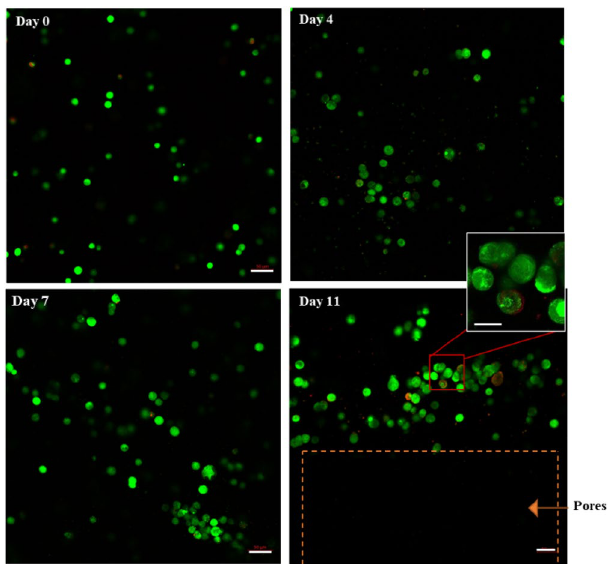
Figure 3. Microscopic images demonstrating viability of MDA-MB-231 cells within 3D hydrogel constructs using the fluorescent live/dead assay kit from day 0 to day 11. Live and dead cells were stained using calcein-AM and PI, respectively (green color represents live cells; red color represent dead cells). Cells were imaged using the laser scanning confocal microscope. Scale bar, 50 μm (enlarged images, scale bar, 30